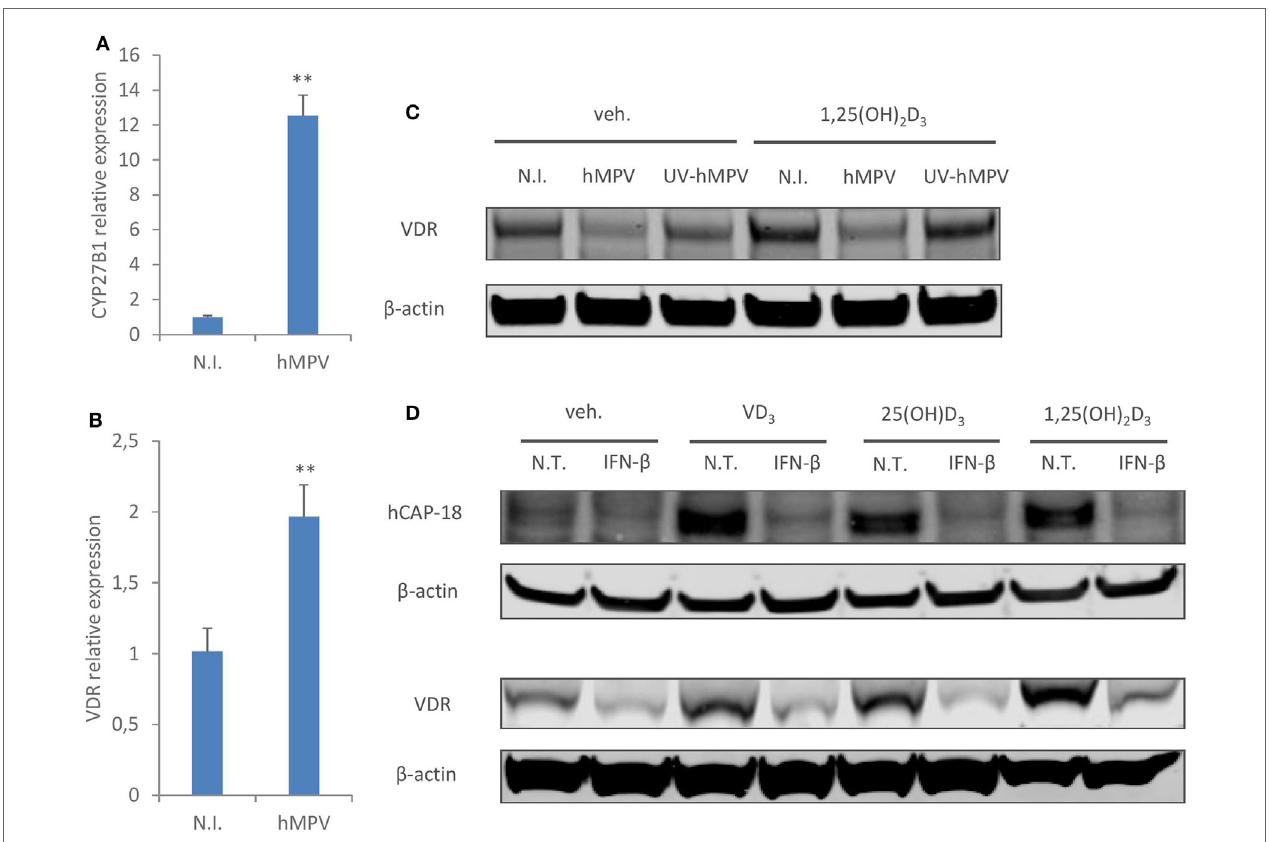
FigUre 3 | Human metapneumovirus (hMPV) infection does not downregulate transcriptional expression of CYP27B1 or vitamin D receptor (VDR), but inhibits VDR protein expression. (a,B) Monocyte­derived macrophages (MDMs) were mock­infected (N.I.) or infected with hMPV for 24 h. mRNA expression of CYP27B1 (a) or VDR (B) was assessed by quantitative real­time PCR. (c) MDMs were mock­infected (N.I.), infected with hMPV or inoculated with UV­inactivated hMPV (UV­hMPV) for 24 h in the presence or absence of 1,25(OH) 2 D 3 . VDR protein expression was assessed by immunoblotting. (D) MDMs were non­treated (N.T) or treated with recombinant interferon­ β (IFN­ β ) for 24 h in the presence or absence of different forms of vitamin D. Cathelicidin antimicriobial peptide (hCAP­18) and VDR protein expression was assessed by immunoblotting. Error bars represent SD for triplicates. ** p < 0.01. Data are representative of at least three independent experiments from different donors. Full­length blots are presented in Figure S1 in Supplementary